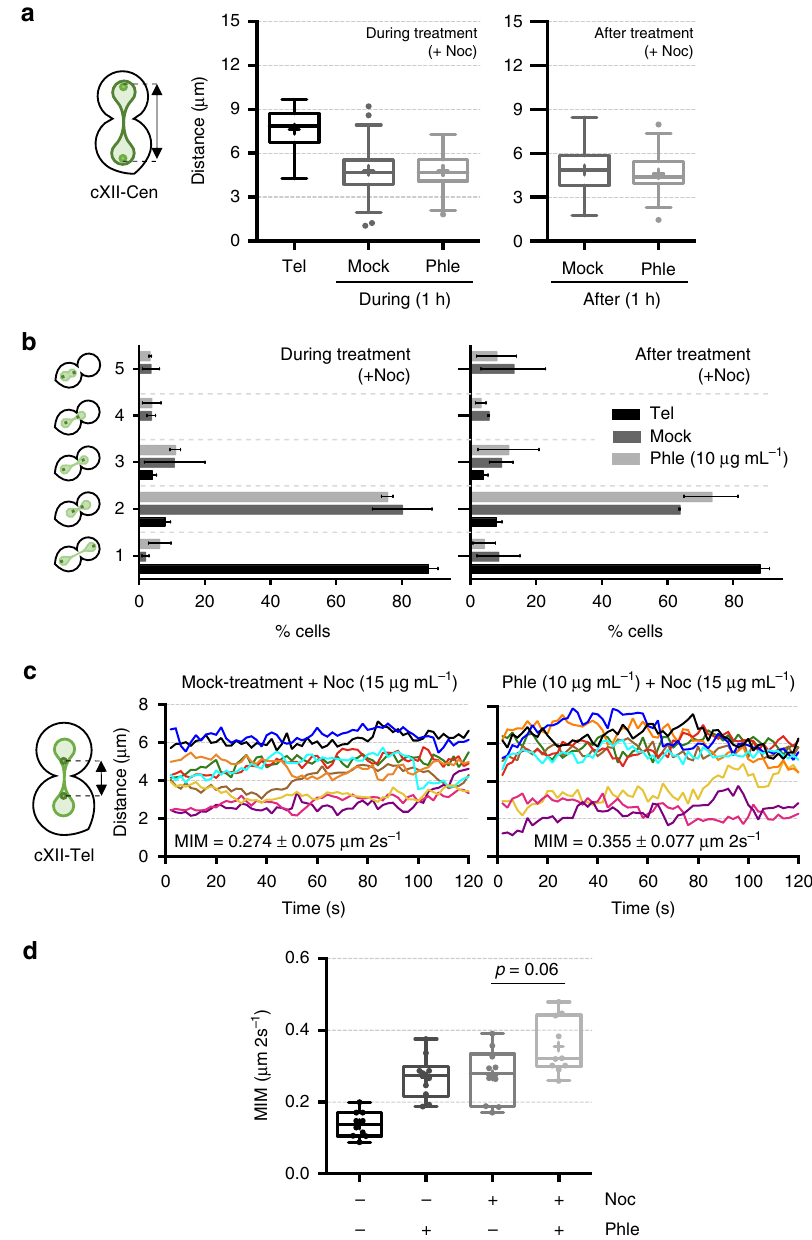
Fig. 7 Microtubule depolymerization masks the effects of DSBs on sister loci approximation. a Sister centromeres also approach each other after depolymerizing telophase microtubules, masking the effect of phleomycin. Strain FM593 was treated as in Fig. 2a, except for the fact that nocodazole (Noc, 15 µ g mL − 1 ) was added at the time of mock/phleomycin treatments and maintained after that. Distance between sister cXII centromeres was measured and box-plotted as in previous experiments. b Relative position of cXII sister centromeres from experiments like in panel ( a ) was categorised as indicated on the left (mean± s.e.m., n = 3 independent experiments). Categories 1 – 4 are described in Fig. 2b. Category 5, two centromeres laying within the same cell body (very rare in Noc-free experiments). c Inter sister telomere movement accelerates upon microtubule depolymerization. Kinetograms of 10 randomly selected FM588 cells previously treated for 1 h with either nocodazole (Noc) alone or Noc plus phleomycin. The MIM during the 2-min movies is also displayed within the charts (mean ± s.d., n = 10 cells). d Box-plots of MIMs ( N = 10 cells per box) at the indicated treatment combinations (1 h